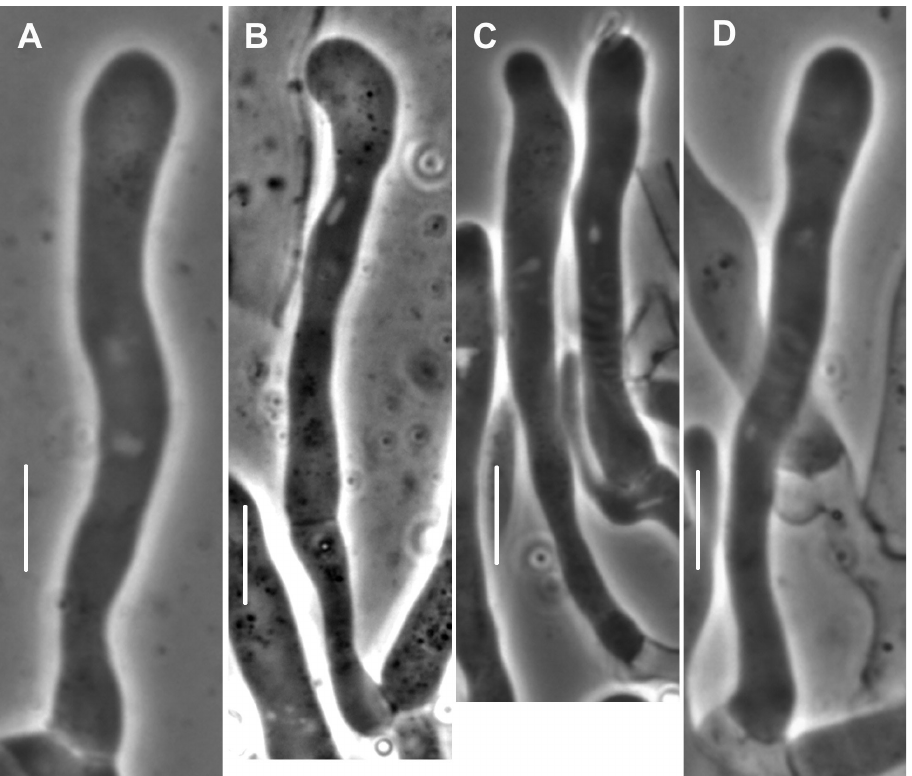
Figure 15. Mycetinis applanatipes . Pleurocystidia. Standard bars = 10 µm. DED 6628 (SFSU-F- 024637).